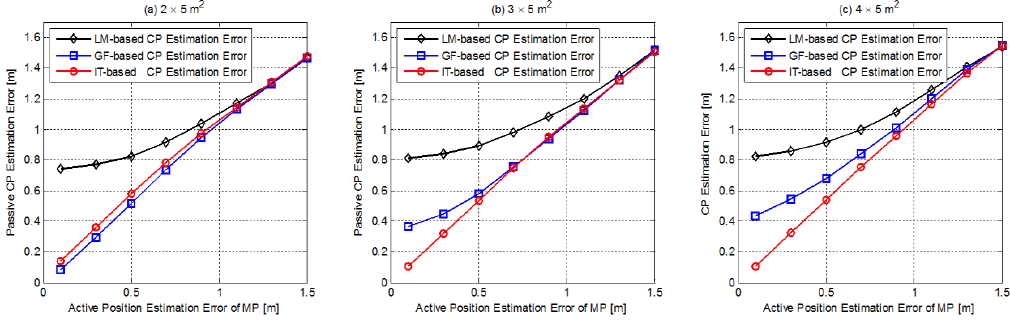
Figure 11. The CP estimation error for the GT schemes versus MP estimation error under different node densities for PATH1.